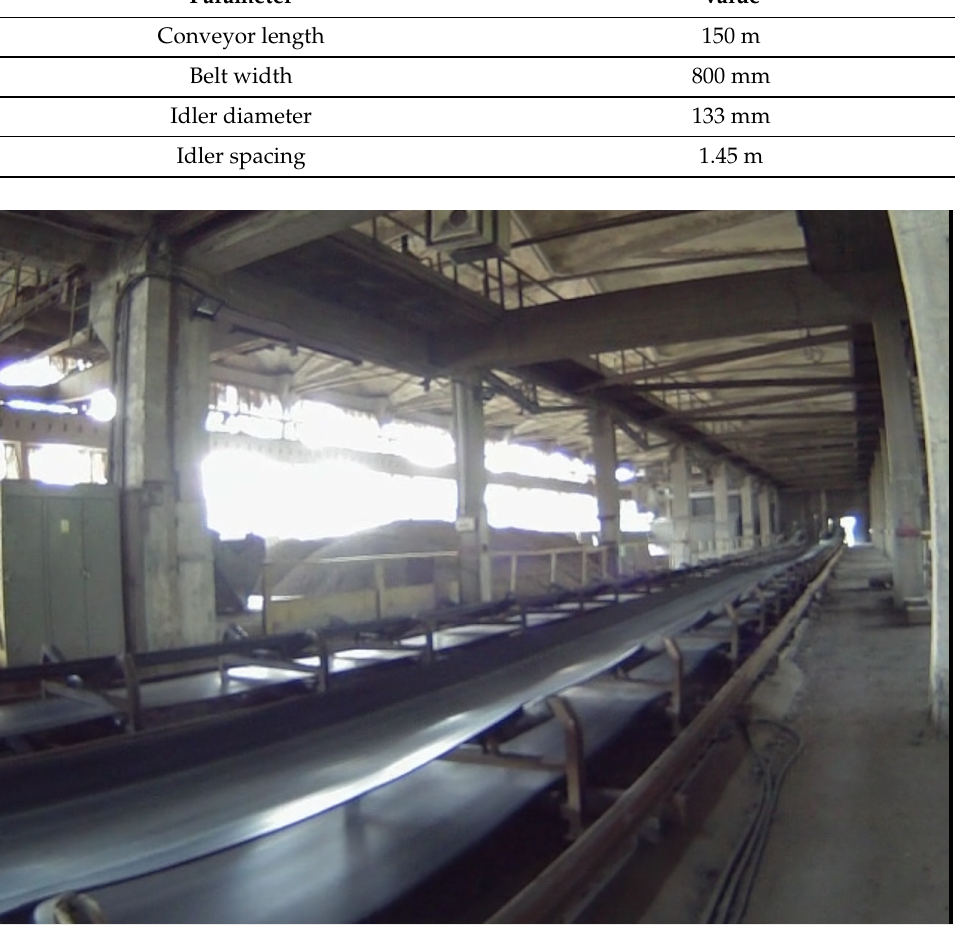
Figure 3. Example of RGB